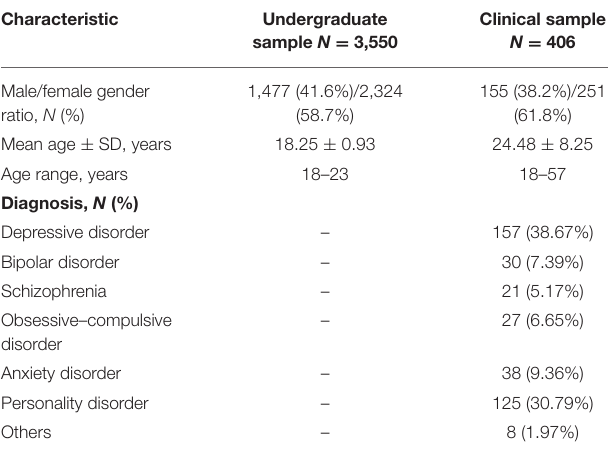
TABLE 1 | Sample characteristics by